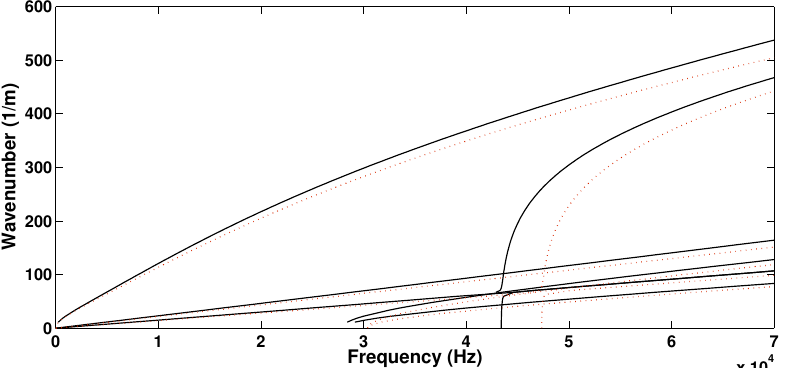
Figure 3. The real part of the wavenumbers propagating at a direction of 45 ◦ within the sandwich panel: sandwich panel with no attached patch ( · · · ), structure with the patch attached to the upper facesheet (piezoelectric coefficients set to zero) (–).